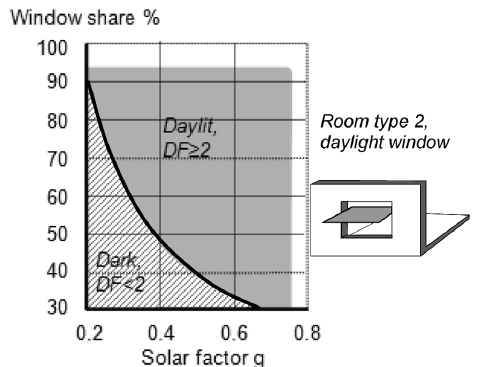
Fig. 7. Possible combinations of window glass share and solar factor for room type 2 that meet the requirement for a daylight factor (DF) ≥